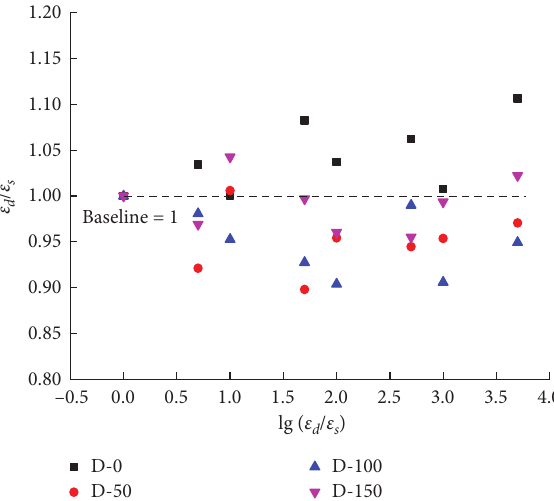
Figure 13: The effect of strain rate on the ultimate strain variation